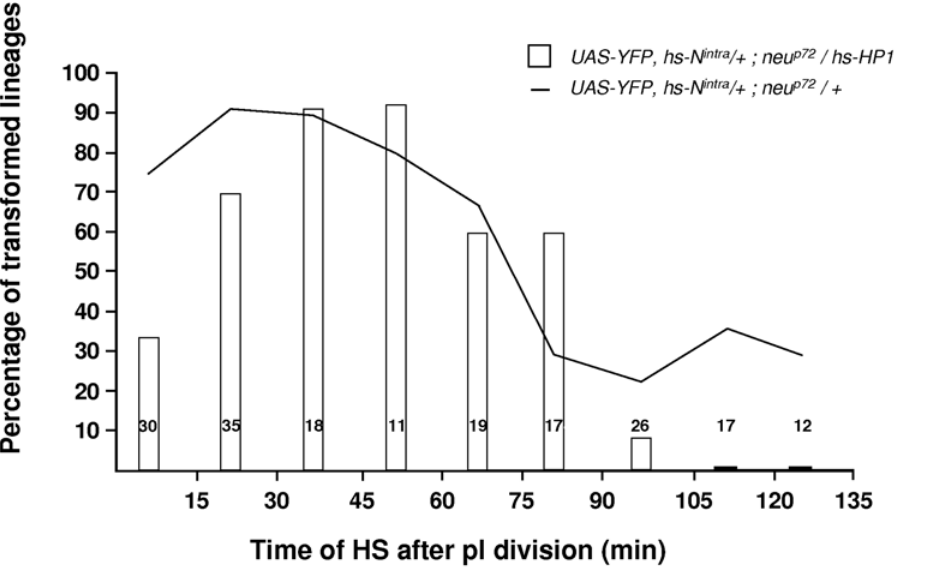
Figure 7. Overexpression of the Heterochromatin Protein-1, HP1, blocks the late residual cellular response to the N pathway. Probability of obtaining transformed sensory organs (resulting from the formation of two pIIa cells) plotted against the moment of overexpression of both N intra and HP1 ( hs . N intra , HP1 pupae). For comparison, the control data ( hs-N intra pupae alone) are presented as a continuous line. These control data are the same as those shown in Fig. 5. Note that when HP1 was expressed late in the G2-phase (between 105 and 135 min), cells became insensitive to N-pathway activation. The HS was applied under visual control in pupae at 19 h APF.